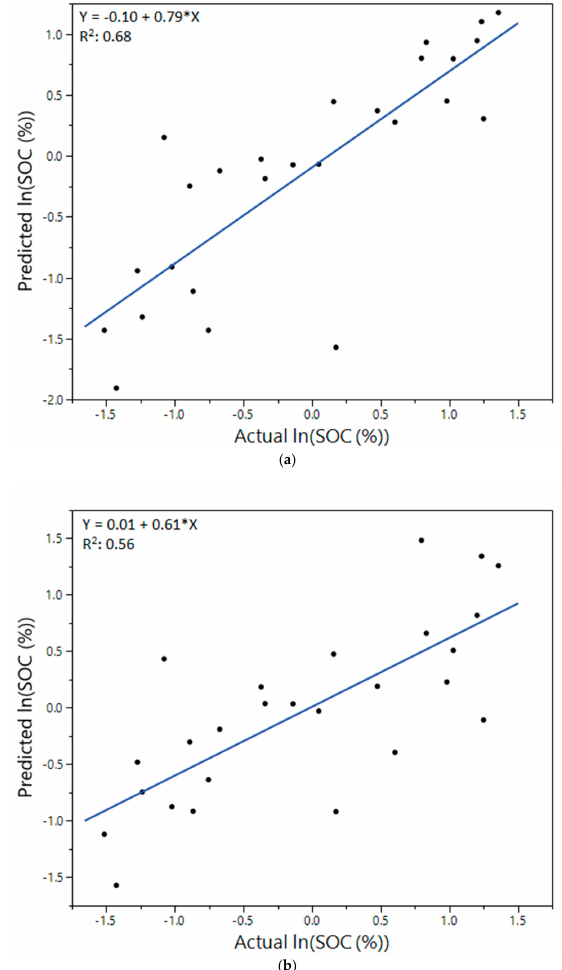
Figure 4. Plots of predicted lnSOC (%) content versus actual lnSOC (%) content for validation data sets for dry soil samples of Alfisols using ( a ) models which included depth and color variables ( p -value < 0.001), and ( b ) models which included only color variables as predictors ( p -value < 0.001). The lnTN (%) prediction model, which included depth and color variables, indicated that depth, L *, and b * were significant predictors of lnTN (%) (Table 4). Cross-validation resulted in a MSPE